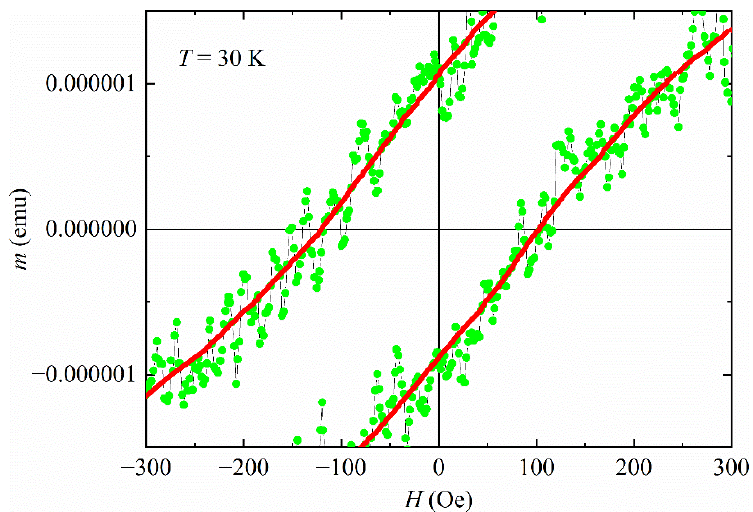
Figure 3. The region near-zero field has been magnified for the m ( H ) curve at T = 30 K. The red solid line is a guide for the eye.